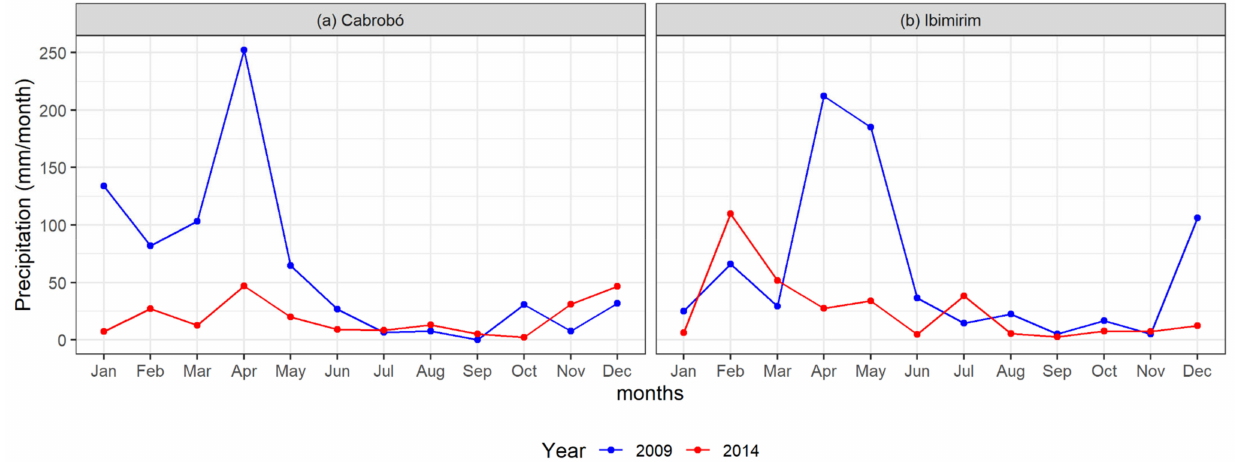
Figure 2. Observed monthly rainfall variability in Cabrob ó and Ibimirim in 2009 (wet year) and 2014 (dry